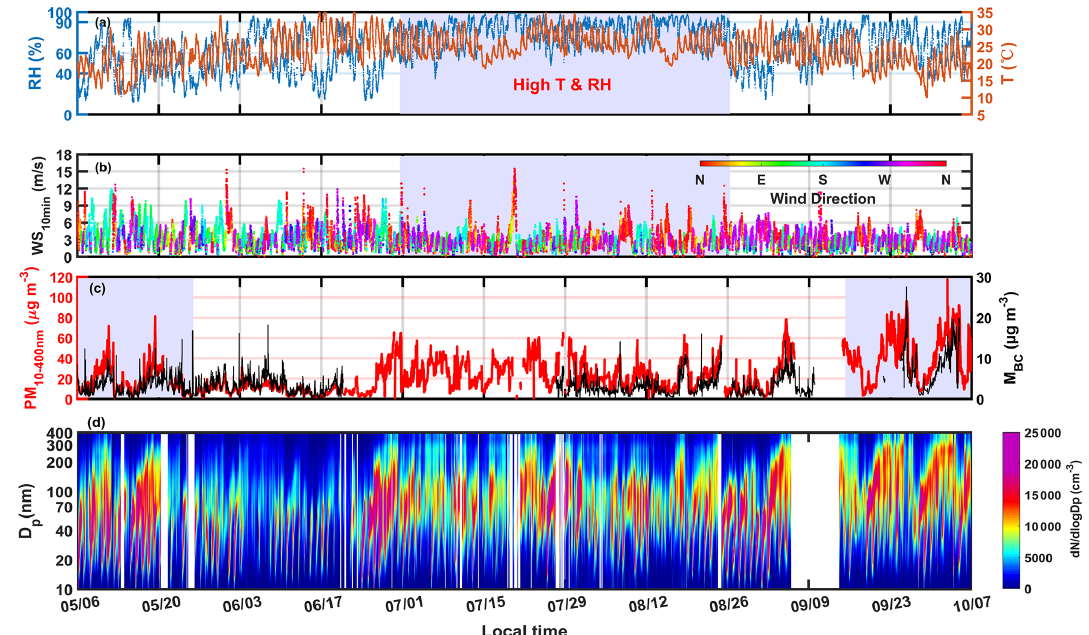
Figure 2. Time series of (a) ambient relative humidity (RH; unit: %) and temperature ( T ; unit: ◦ C), (b) wind direction (WD) and 10min- averaged wind speed (WS; unit: ms − 1 ), (c) mass concentration of 10–400nm particles (PM 10 − 400 , in red; unit: µgm − 3 ), assuming that the aerosol density is 1.6gcm − 3 , and mass concentration of black carbon ( M BC , in black; unit: µgm − 3 ), and (d) particle number size distribution at the Xingtai site from 6 May 2016 to 6 October 2016.